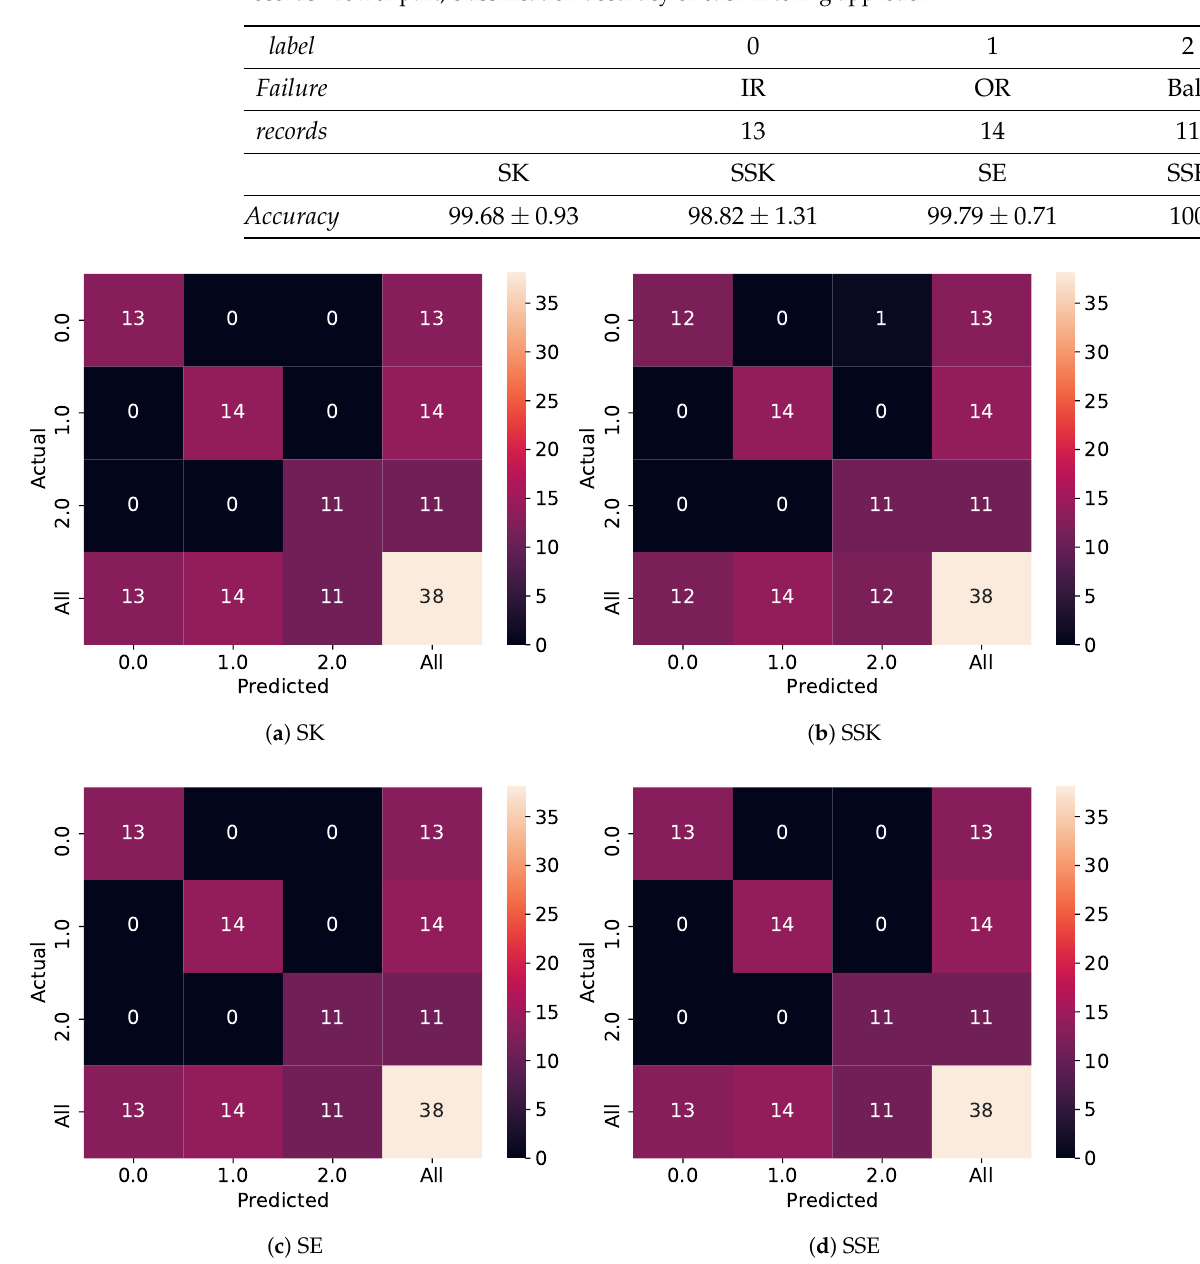
Figure 12. Confusion matrix of classification stage in UNC dataset, using SK, SSK, SE, and